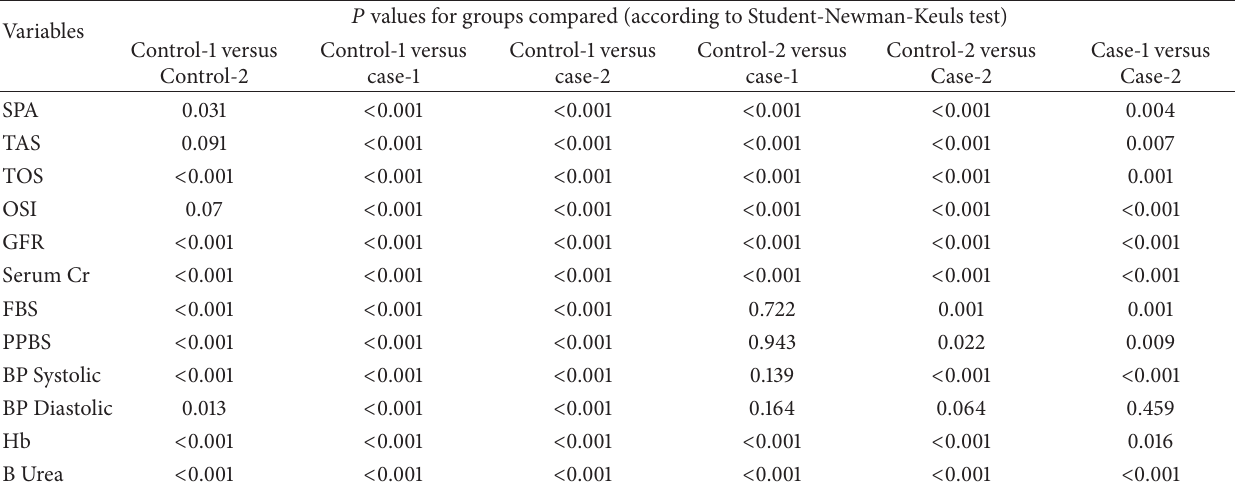
Table 3: Representation of Student-Newman-Keuls test’s 𝑃 value for different variable and multiple comparison groups. 𝑃 values for groups compared (according to Student-Newman-Keuls Variables